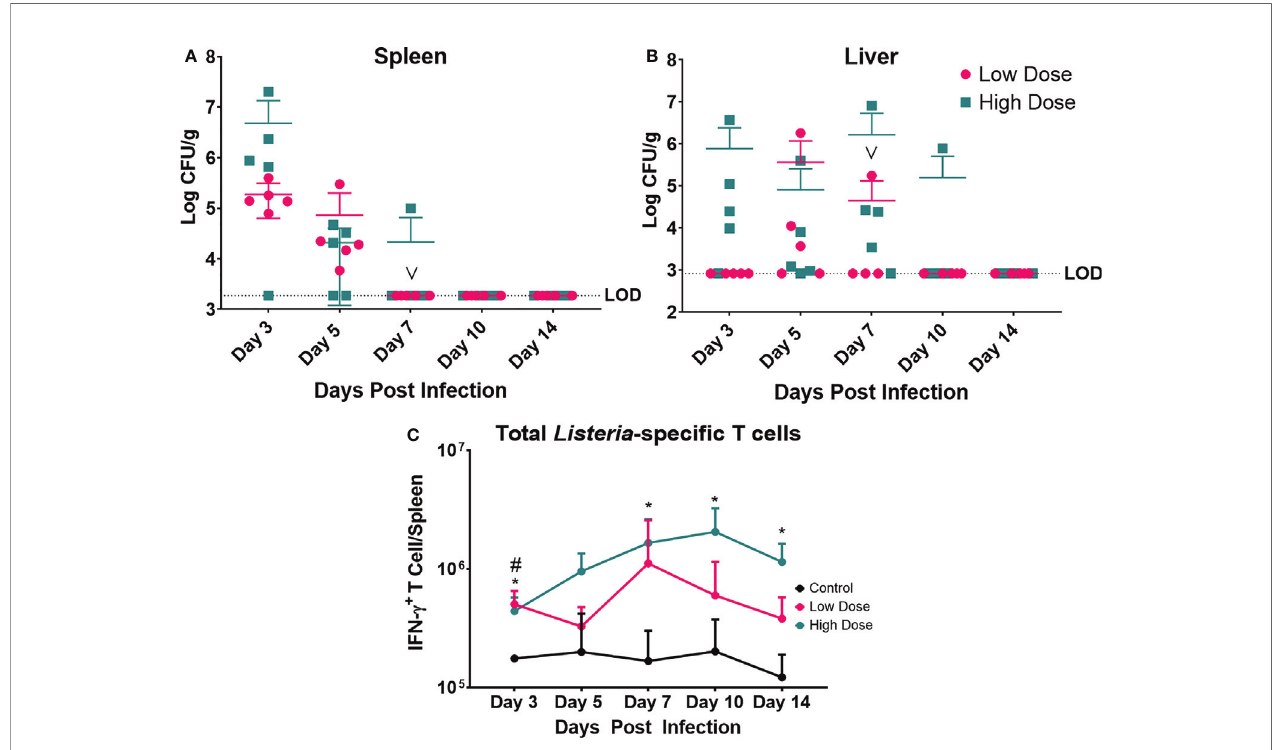
FIGURE 4 | Bacterial Enumeration and Listeria -speci fi c T cell response. Bacterial burden at various time points following a Listeria infection in the (A) spleen and (B) liver. LOD indicated limit of detection. Data are represented as mean ± SD. High Dose (n = 5), Low Dose (n = 5). (C) Listeria -speci fi c IFN- g producing T cells were enumerated at various time points post infection in the spleen following a Listeria infection. Statistical analysis was performed by a Mixed-effect analysis followed by a Dunnett Test for multiple comparison. Data are represented as mean ± SD. * indicates a signi fi cant between High Dose (n = 5) - Control (n = 3) and # indicates a difference between Low Dose (n = 5) - Control (n = 3). * p < 0.05, # p < 0.05. v indicates a mouse death in the day 7 post infection low dose